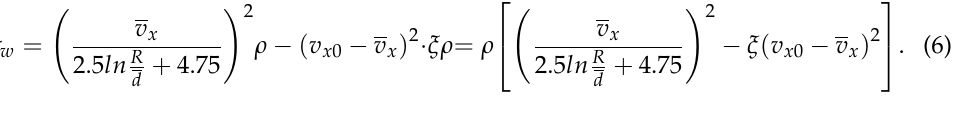
Figure 4. Shear erosion theory model.